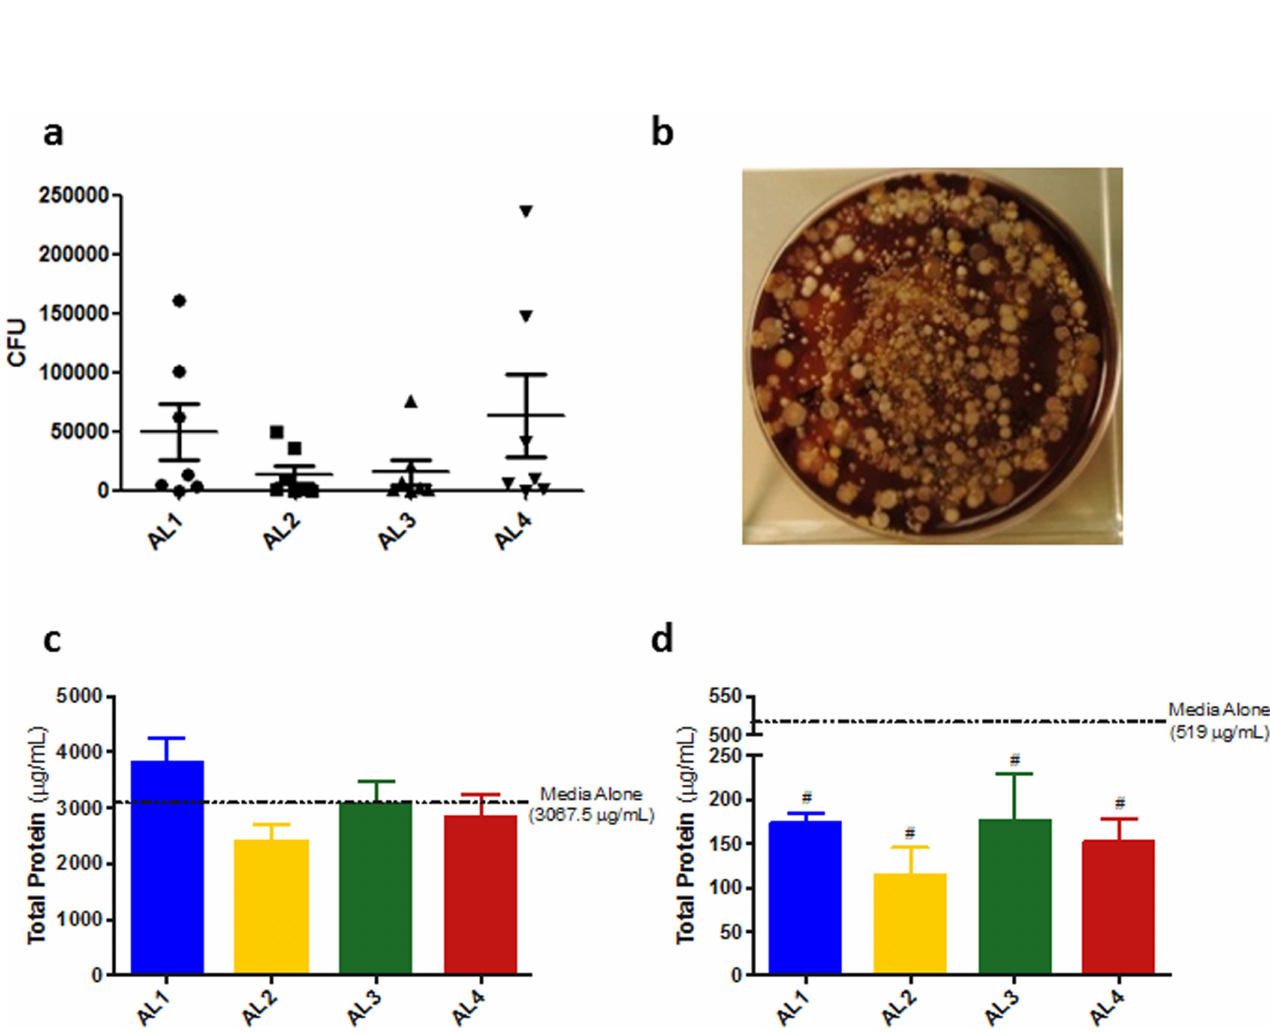
Fig 4. Bacterial load and culture. (a) Number of colony forming units (CFU) for each anatomic location (n = 7/AL). One-way ANOVA revealedno significant differences between anatomic locations. (b) Representative 1-10-folddilution of CFU plates is displayedshowinga diverse polymicrobial community. Protein content is similar between anatomic locationsfor MEM-BTM (c) and KM-BTM (d). KM-BTM had a significant reduction in protein content compared to KM alone (p = 0.004) however MEM-BTM did